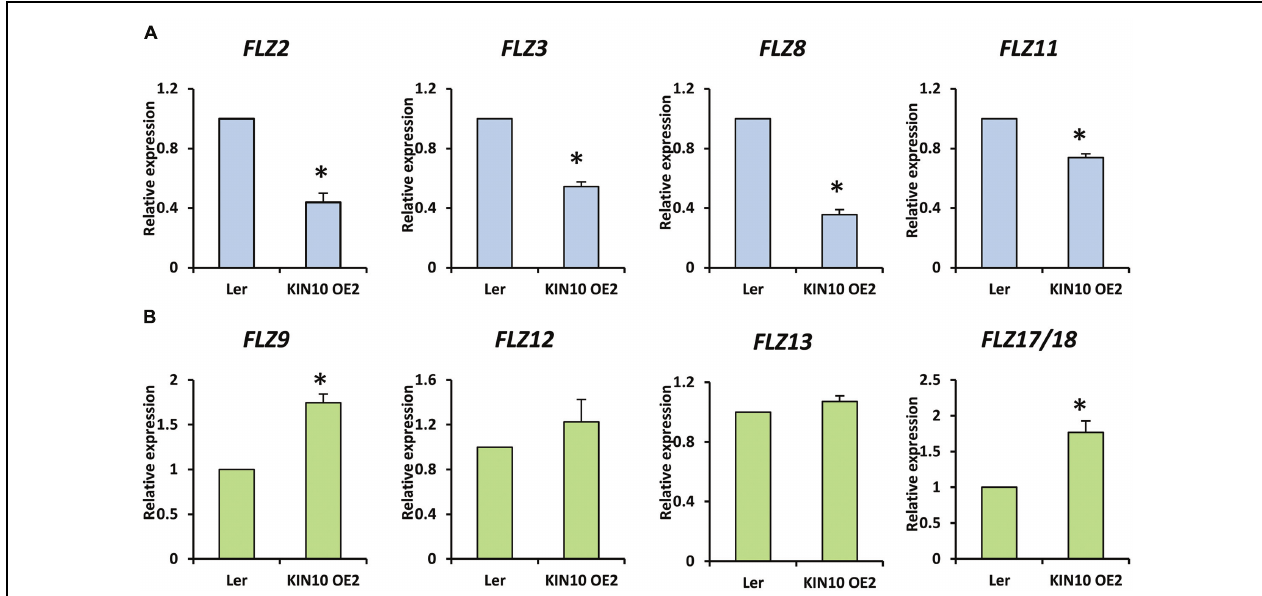
FIGURE 6 | Expression of FLZ genes in SnRK1.1 over-expression line. The transcript level of selected FLZ genes in KIN10 OE2 seedlings were studied with qRT-PCR. (A) The expression of sugar-inducible (Class I and II) FLZ genes in KIN10 OE2 . (B) The expression of Class III FLZ genes in KIN10 OE2 . The expression in 5-days old Ler was used as the control to compare the transcript level of FLZ genes in KIN10 OE2 . UBQ10 was used as endogenous control. The bars represent the average of two independent biological experiments with three technical replicates each and error bars represent SE. Single asterisk indicates a significant difference of expression in KIN10 OE2 compared to Ler ( P < 0.005, Student’s t -test).